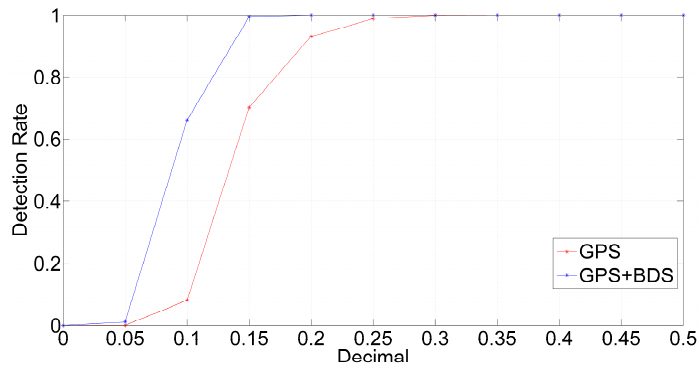
Figure 13. The detection rates under different decimals.